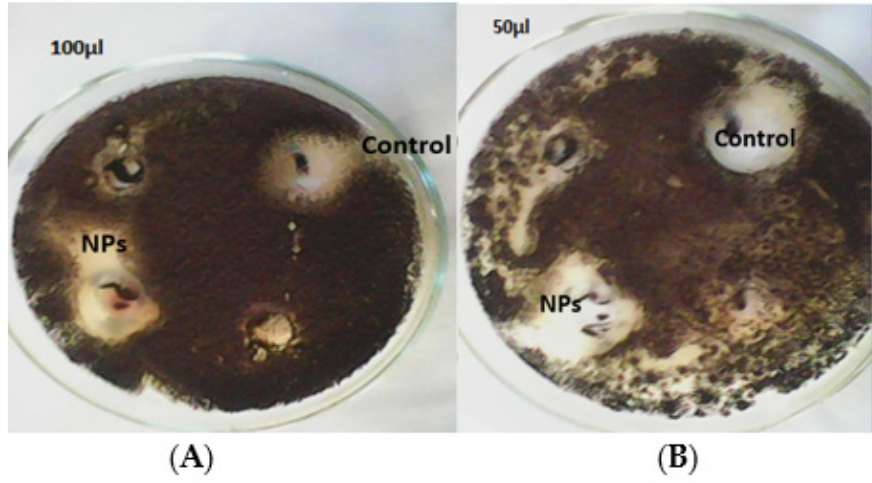
Figure 9. Antifungal activity of ( A ) bulb-capped AgNPs and ( B ) leaf-capped AgNPs against Aspergillus niger.